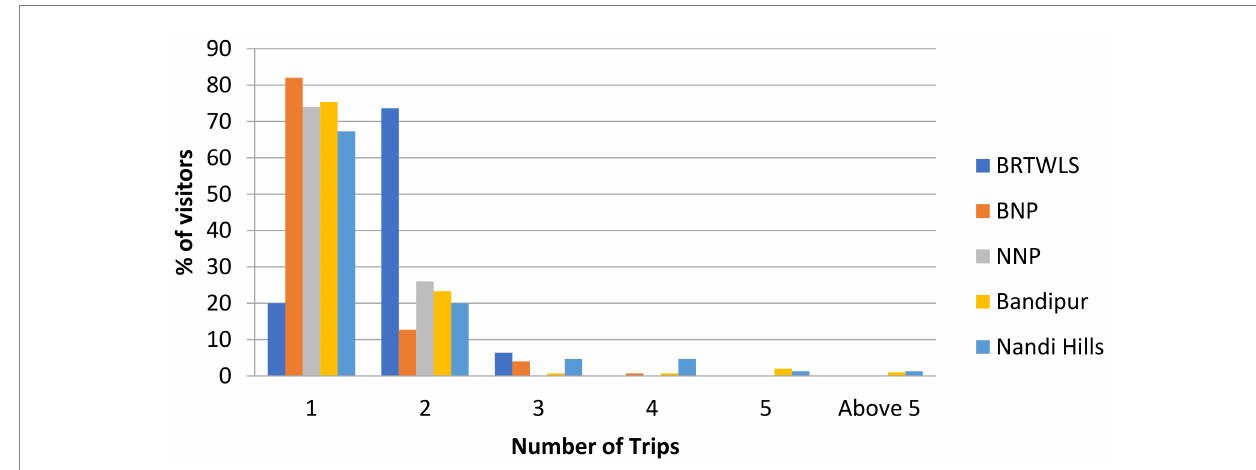
FIGURE 2 Frequency of tourist trips to the protected areas in the Western Ghats.